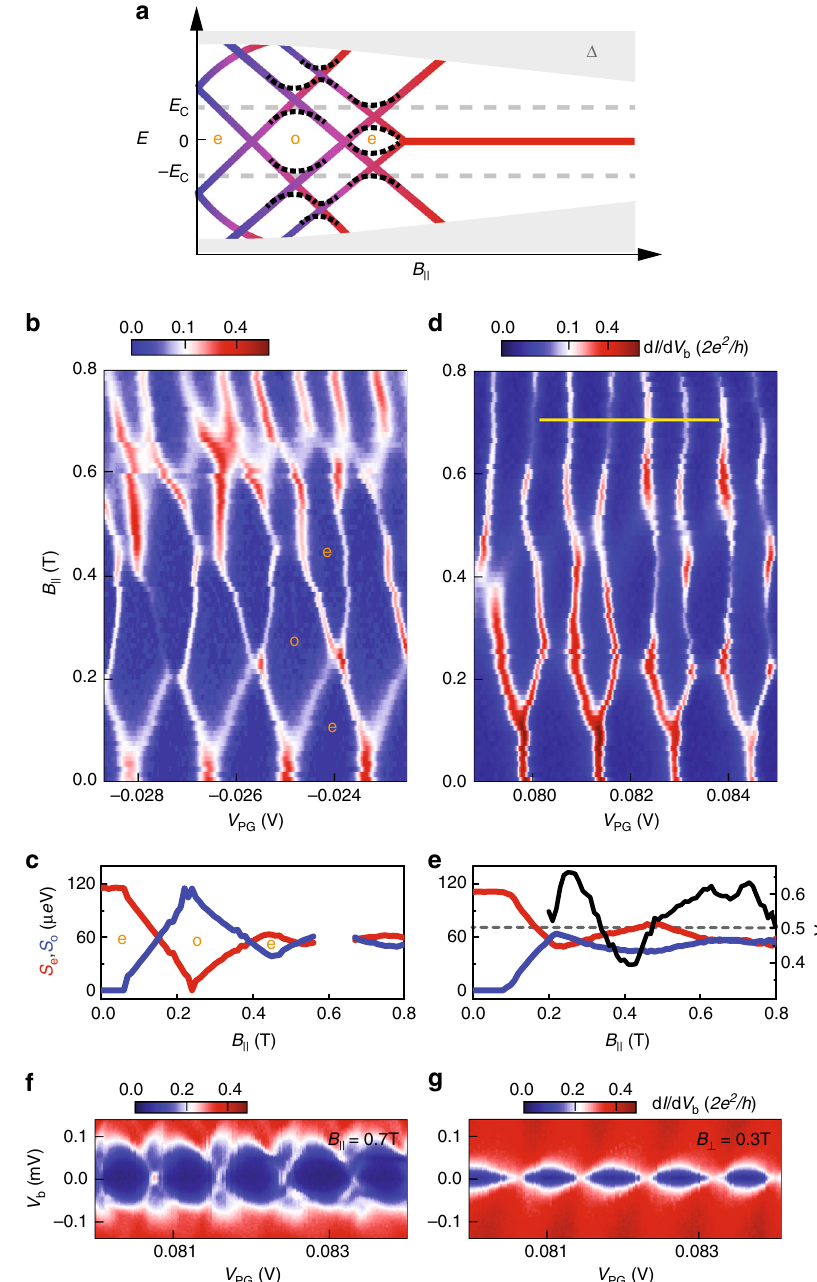
Fig. 4 Evolution of multiple subgap states. a Schematic B - fi eld dependence for the case of three subgap states with GS parity transitions at each zero- energy crossing. Dashed lines indicate level repulsion between different subgap states, leading to large oscillations of the lowest energy E 0 . b One example of Coulomb peaks re fl ected by the scenario in panel a . The extracted peak spacings for the valleys labelled by e and o are shown below in c . The evolution of the peak spacings is compatible with the type of energy spectrum shown in a characterised by large oscillations of E 0 . Note that the odd-parity GS around ~0.2 T develops a full 2 e -periodicity. (The spacings near ~0.6 T are absent because the exact peak positions are unclear.) d Another example of Coulomb oscillations with a pronounced B - fi eld dependence. Extracted peak spacings and the height ratio are shown in e (averaged over the three periods in d ). f Coulomb diamonds at B ∥ = 0.7 T along the V PG -range indicated by the yellow line in d . This bias spectroscopy reveals isolated zero-bias peaks at the charge-degeneracy points that are separated from the continuum. As in Fig. 2c, neighbouring zero-bias peaks have different heights (also visible in d at high B ∥ ). g Bias spectroscopy with Al in the normal state ( B ⊥ = 0.3 T) where the isolated zero-bias peaks are